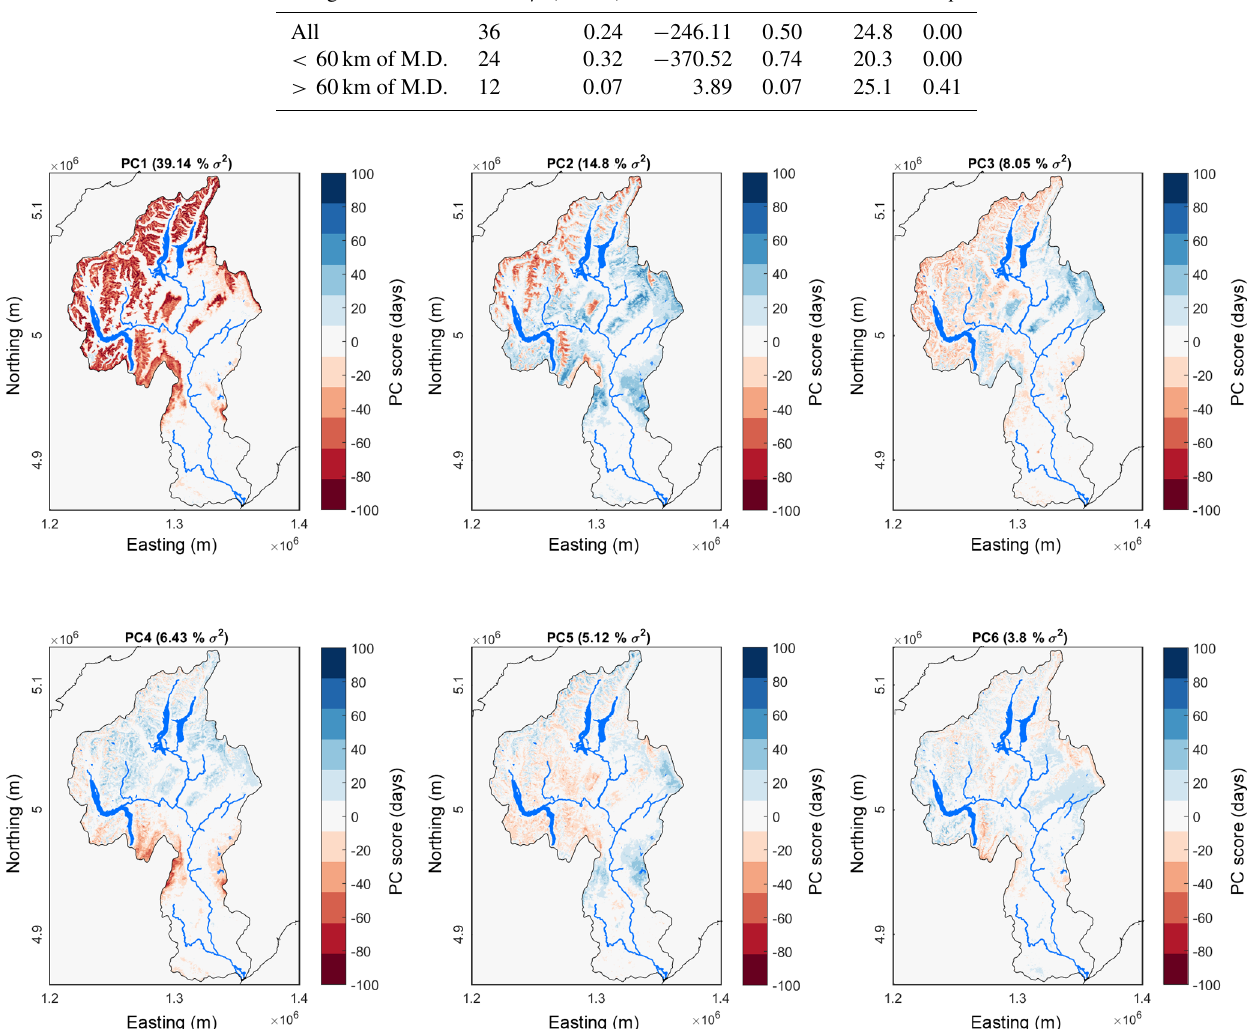
ship weakens substantially and loses significance (Table